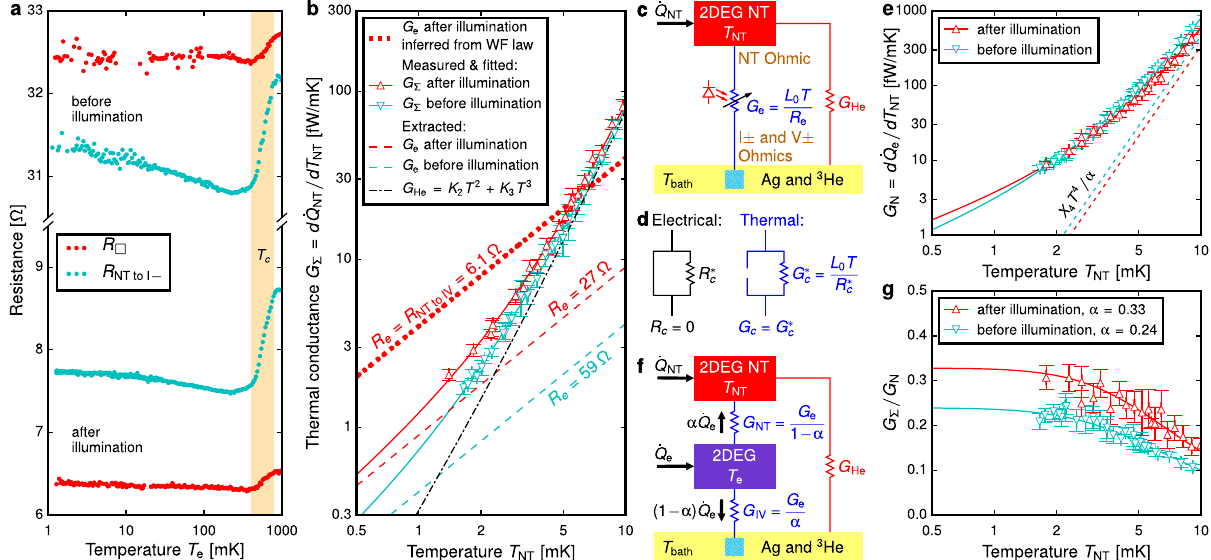
Fig. 3 Transport measurements of 2DEG and ohmic contacts. a Sheet resistance R □ of the 2DEG (red) and the resistance including 2DEG and two ohmic contacts (cyan) measured down to 1 mK. Weak temperature dependence of the resistance is observed in both the 2DEG and the ohmic contacts below the superconducting transition in the contacts which occurs at T c = 0.6±0.2K. The electron temperature T e is determined from Eq. (4). b Thermal conductance G Σ between 2DEG NT and 3 He bath before (cyan) and after (red) illuminating the 2DEG, modelled as a sum of two parallel channels ( c ): the 2DEG and ohmic contacts, sensitive to illumination, and G He due to immersion of the gold wires in liquid helium. Assuming the Wiedemann-Franz (WF) law applies in the 2DEG and ohmic contacts, after illumination the electron channel G WF violation of the WF law to superconductivity within the ohmic contacts. The effective electrical resistance R e is obtained by fi tting G Σ ( T ) in ( b ) to Eq. (1). d In the partially-superconducting ohmic contact model the thermal conductance at T ≪ T c is determined by the non-superconducting channel R (cid:2) c according to the WF law. e Response of the 2DEG NT to heating the 2DEG, the non-local thermal conductance G N , is obtained analogously to G Σ and fi tted to Eq. (2). Dashed lines show the X 4 T 4 term in Eq. (2), unimportant below T NT = 3 mK. f A lumped-element thermal model described by Eqs. (3) and (4), in which _ Q e is assumed to be applied in the centre of the 2DEG, splitting G e into G NT and G IV , each including the 2DEG and the ohmic contacts. g The ratio G Σ / G N describes the fraction of _ Q e that fl ows into the NT. The T → 0 limit α of G Σ / G N governs G NT and G IV in ( f ). Error bars in b , e , g represent